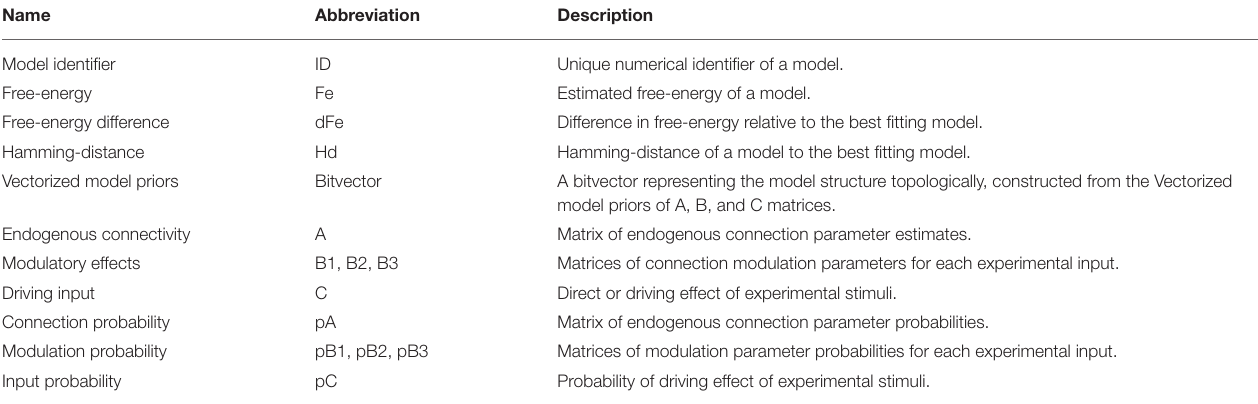
TABLE 1 | Model-space database